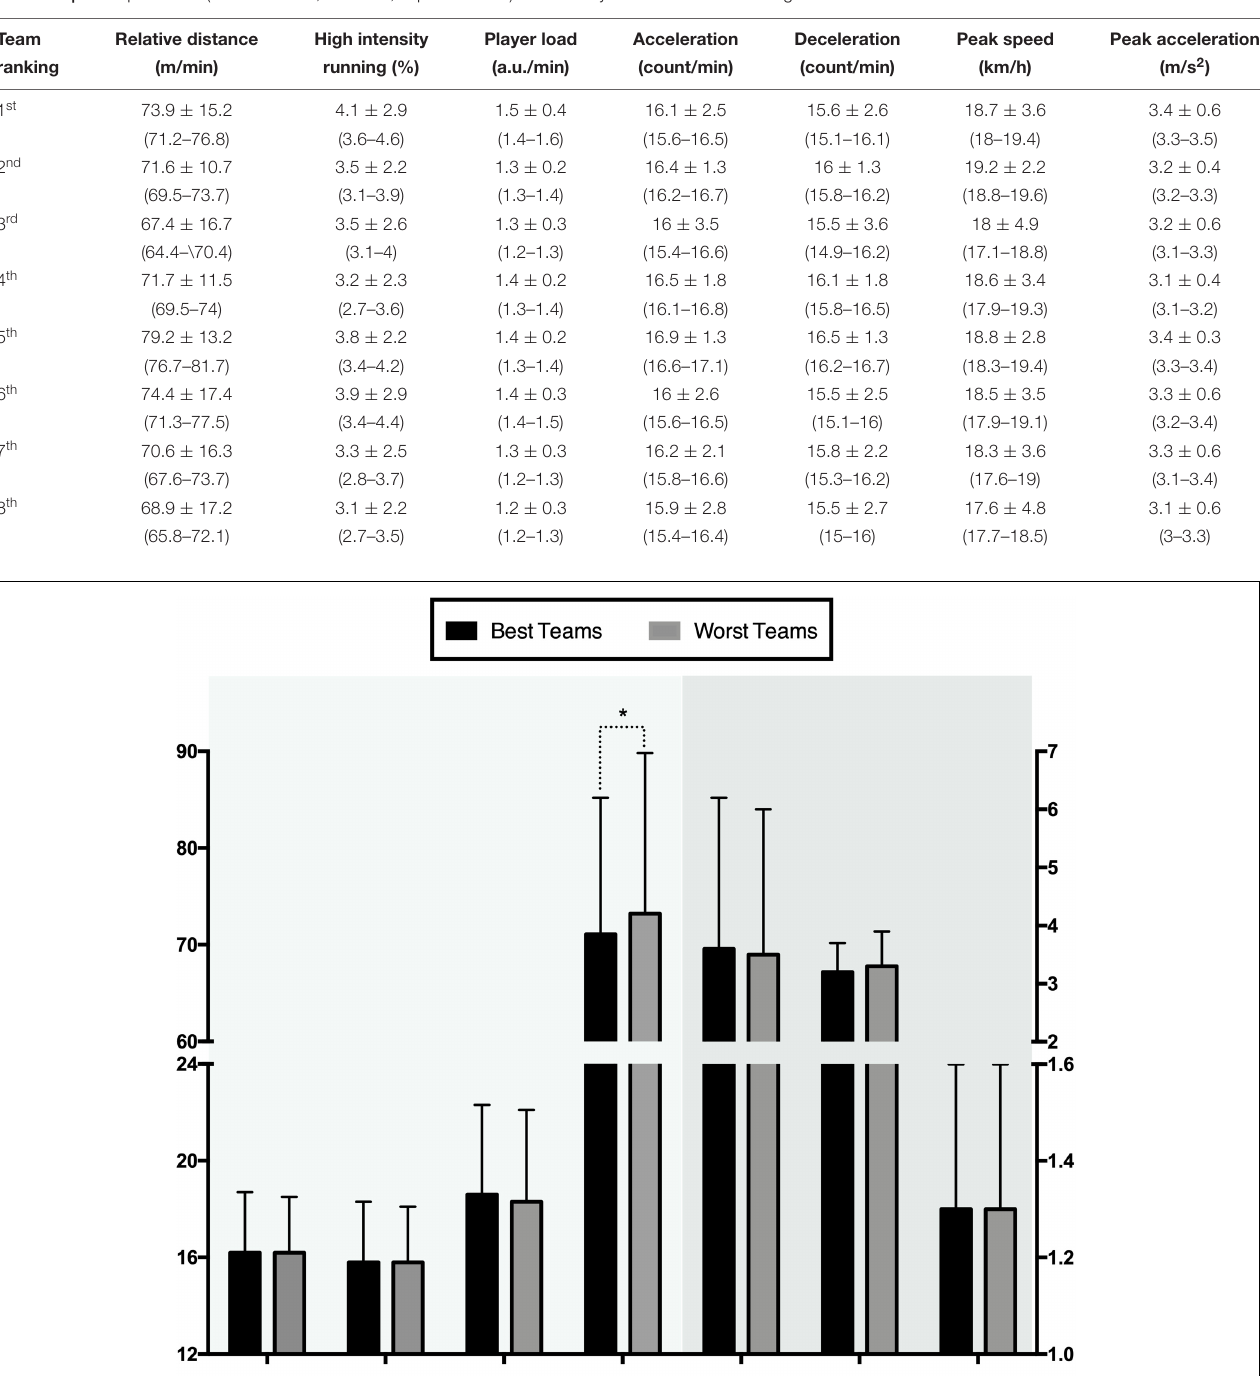
TABLE 2 | Descriptive data (means ± SDs; 95% CIs, in parentheses) of teams by final tournament ranking.